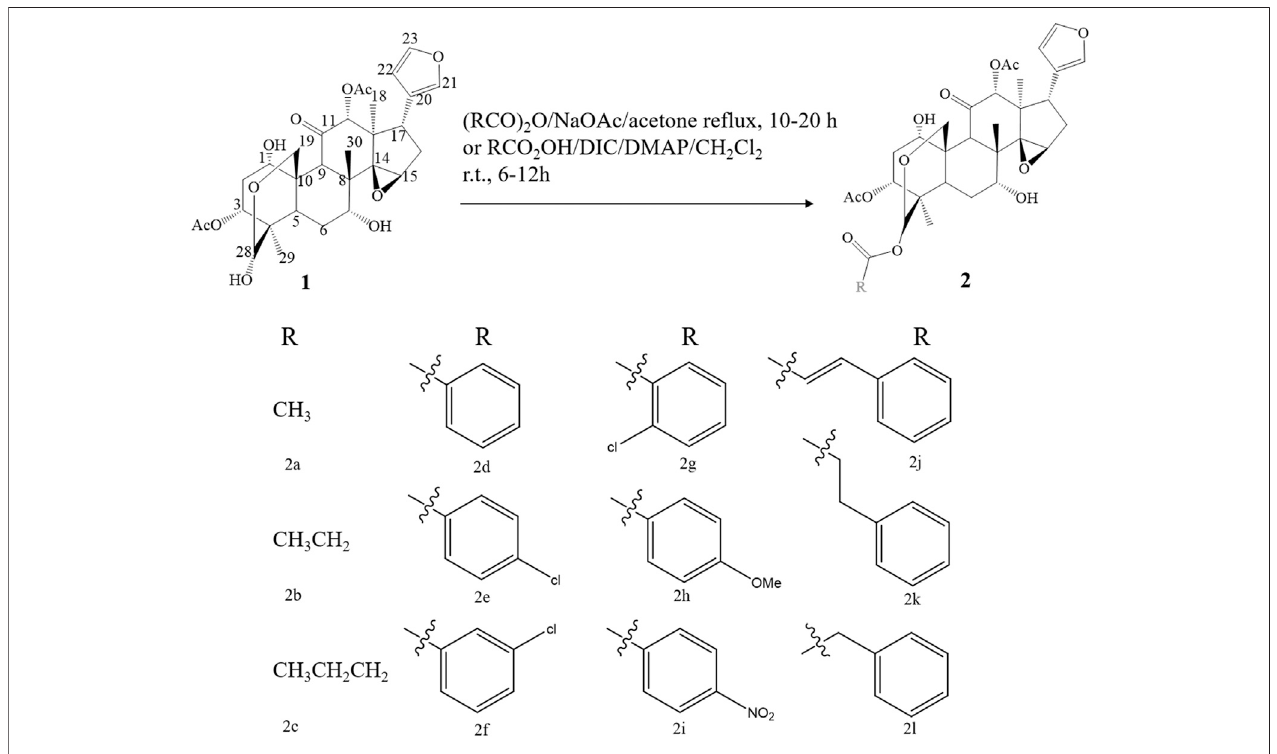
FIGURE 8 | The synthetic route of 28-acyloxy derivatives of toosendanin.